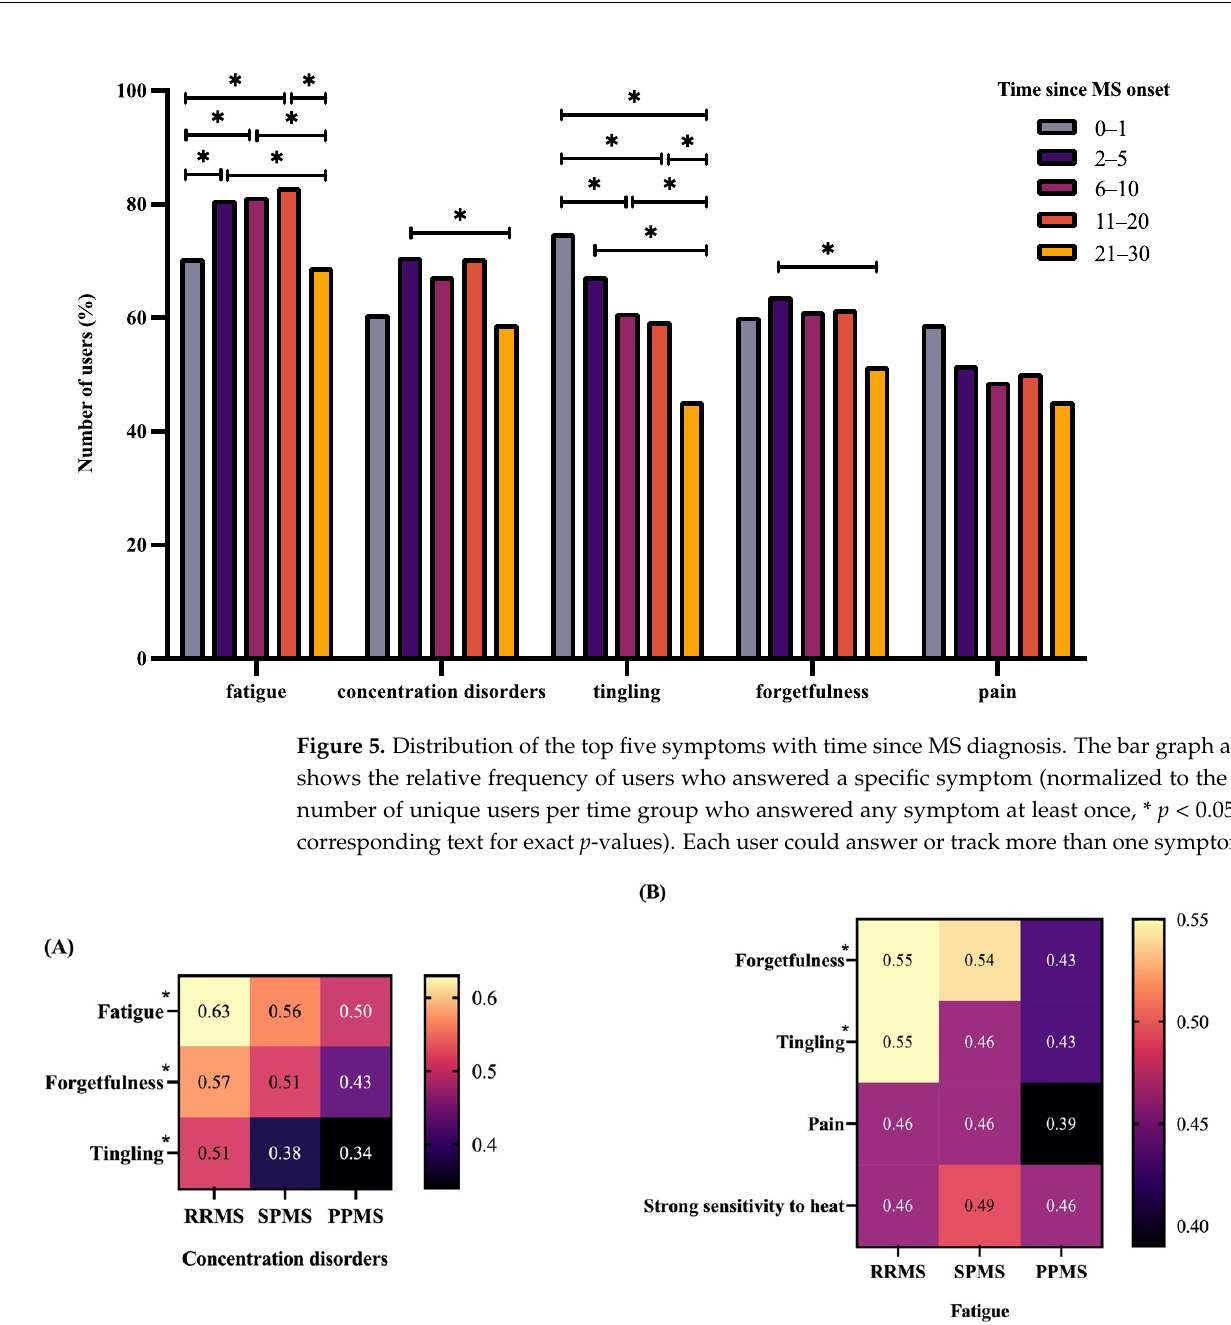
Figure 6. Symptom pairs tracked by BRISA users. The heat map above shows the relative frequency of two symptoms being answered or tracked by a user. The raw frequencies were normalized to the total number of users (with a specific type of MS) who answered at least one symptom once after onboarding. Only symptom pairs greater than the threshold (>0.45 in RRMS) were mapped. * p < 0 . 05, see corresponding text for exact p -values. ( A ) Symptom combinations with concentration disorders. ( B ) Symptom combinations with fatigue.